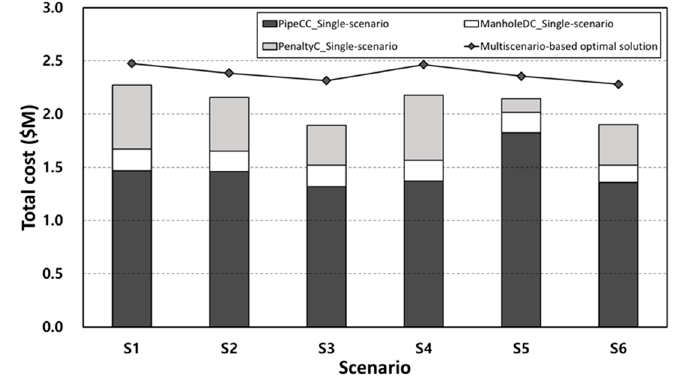
Figure 9. Comparison of the final total costs between scenario-optimal solutions and multi-scenario- based compromise solution.